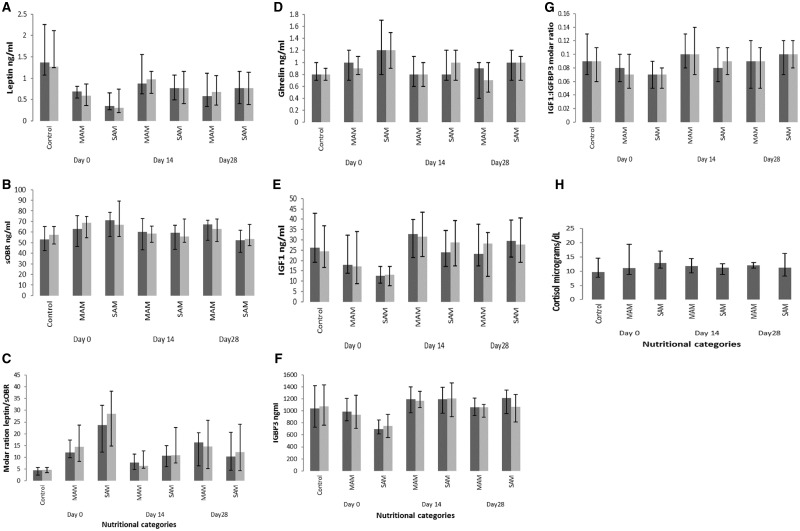
Changes in hormone and receptor levels over time by nutritional category. (A) Leptin levels in nanograms per millilitre. Dark grey bars = pre-test meal levels, pale grey bars = post-test meal levels. (B) sOBR levels in nanograms per millilitre. Dark grey bars = pre-test meal levels, pale grey bars = post-test meal levels. (C) Molar excess of sOBR/leptin. Dark grey bars = pre-test meal levels, pale grey bars = post-test meal levels. (D) Total ghrelin in nanograms per millilitre. Dark grey bars = pre-test meal levels, pale grey bars = post-test meal levels. (E) IGF-1 in nanograms per millilitre. Dark grey bars = pre-test meal levels, pale grey bars = post-test meal levels. (F) IGFBP3 in nanograms per millilitre. Dark grey bars = pre-test meal levels, pale grey bars = post-test meal levels. (G) Molar excess of IGF-1/IGFBP3. Dark grey bars = pre-test meal levels, pale grey bars = post-test meal levels. (H) Pre-prandial cortisol in micrograms per decilitre.